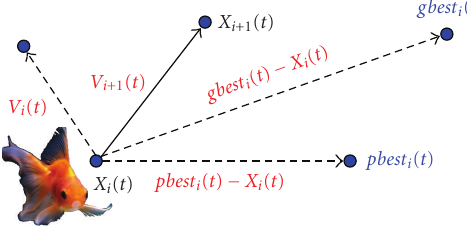
Figure 1: Movement of each